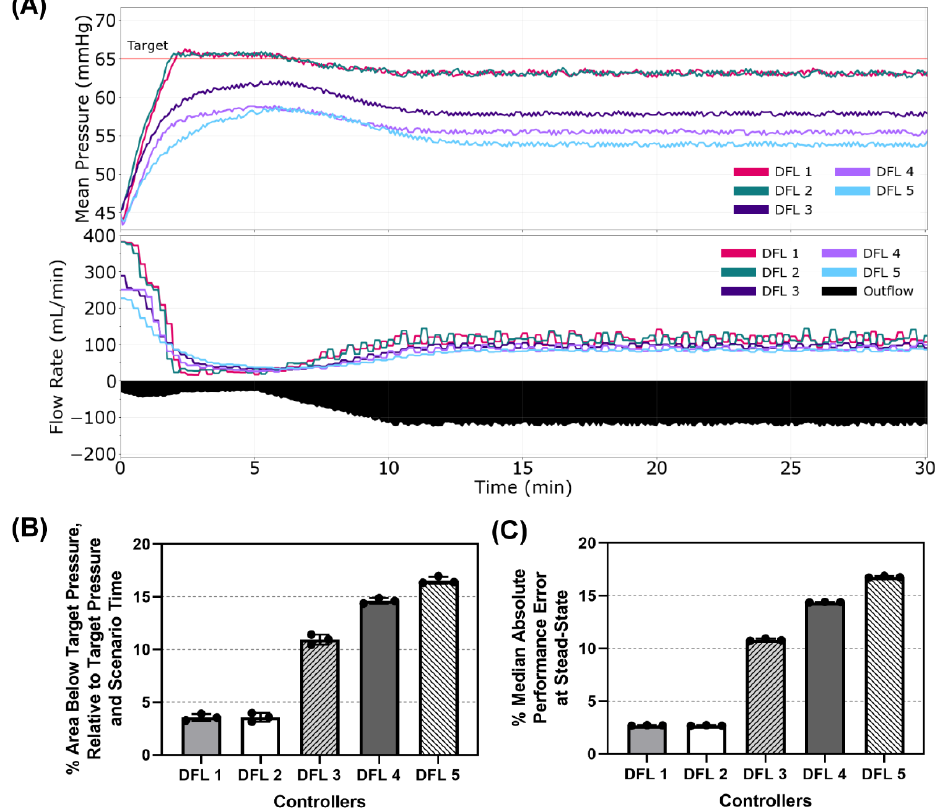
Figure 7. Dual-input fuzzy logic results for Scenario 4. Scenario 4 began with a MAP of 45 mmHg with an active hemorrhage slowing for the first 5 min and then accelerating to a maximum hemorrhage rate to mimic coagulopathy, with a resuscitation goal of 65 mmHg MAP. ( A ) Five controller designs MAP and infusion rate vs. time are shown for one replicate run. A single representative outflow vs. time result is shown. ( B ) The area below target pressure and ( C ) median absolute performance error at steady state performance metrics for each controller design are shown as mean values from three subject variability runs, with error bars denoting standard deviation.